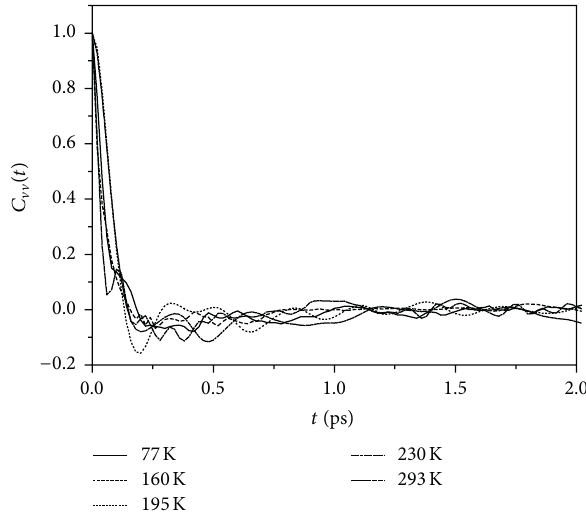
Figure 9: The velocity autocorrelation function of hydrogen molecules for the different temperature at 10kPa.